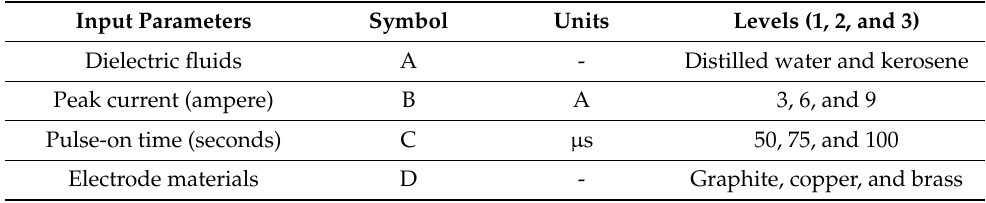
Table 5. Machining inputs process parameter with their levels.